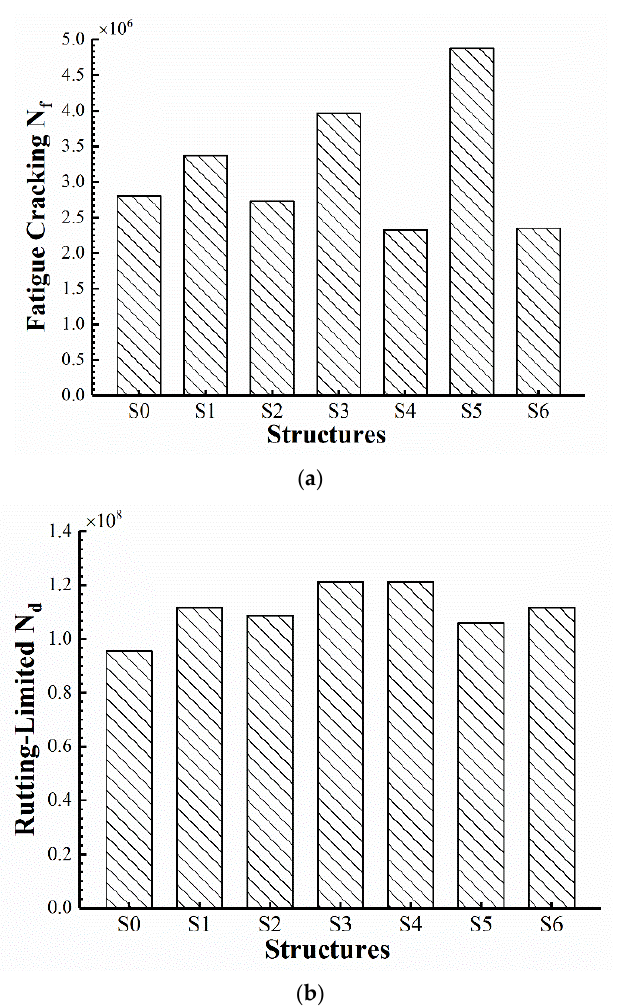
Figure 11. The allowable load repetitions: ( a ) 𝑁 (cid:3033) to limit fatigue cracking; ( b ) 𝑁 (cid:3031) to limit rutting. Meanwhile, the aging of the asphalt binder is also related to the expected service life of the asphalt mixture. In fact, the aging properties of the epoxy asphalt have been studied by several researchers, and it has been proven that the addition of epoxy com- ponents can provide epoxy asphalt with much better aging resistance. Apostolidis et al. [46] tracked the formation of carbonyl compounds by Fourier transform infrared (FTIR) spectroscopy and found that its reaction rate decreased when the epoxy components were added to the asphalt, which indicates that oxidative aging in epoxy asphalt occurs